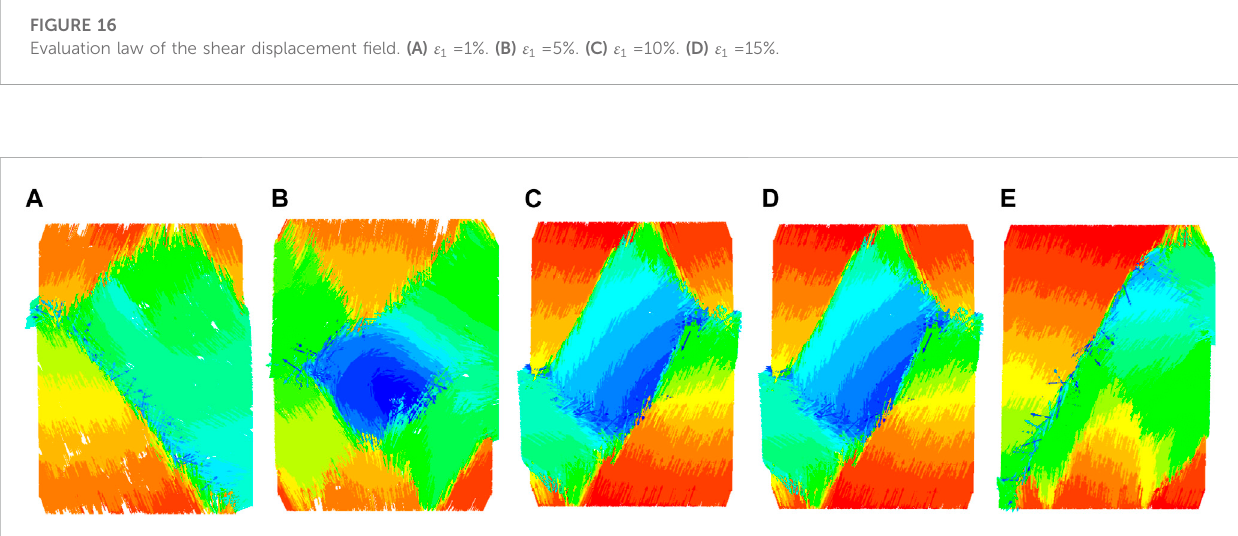
FIGURE 17 Shear displacement fi elds of fi ve types of calcareous sand. (A) Shear displacement fi eld of calcareous gravel sand. (B) Shear displacement fi eld of calcareous coarse sand. (C) Shear displacement fi eld of calcareous medium sand. (D) Shear displacement fi eld of calcareous fi ne sand. (E) Shear displacement fi eld of calcareous silt.